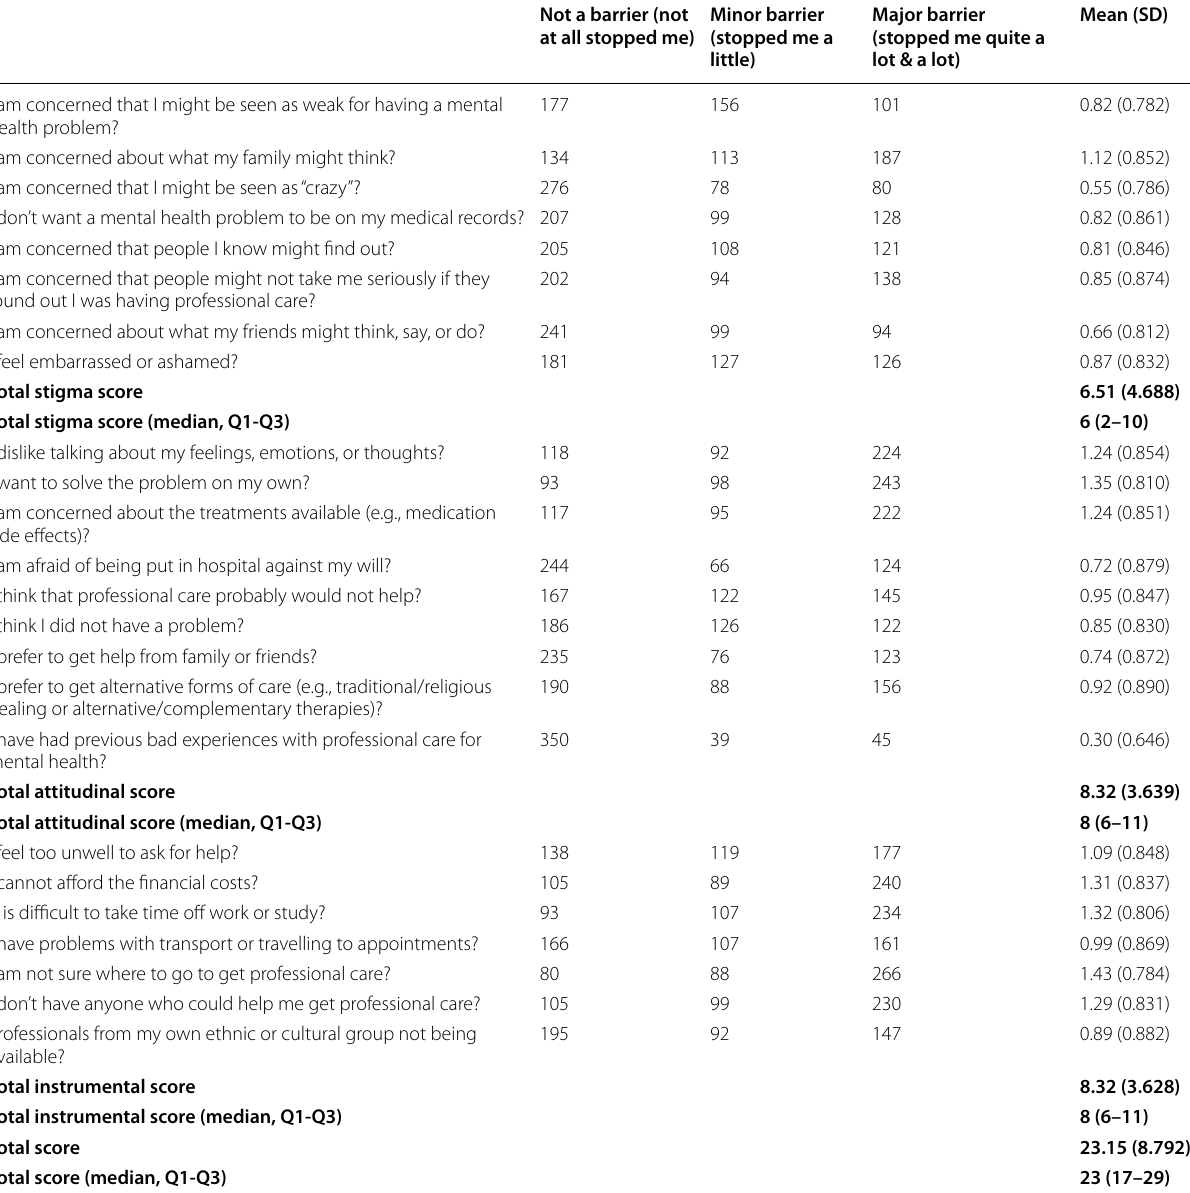
Table 3 Barriers to Access to Care Evaluation (BACE) as perceived by medical students